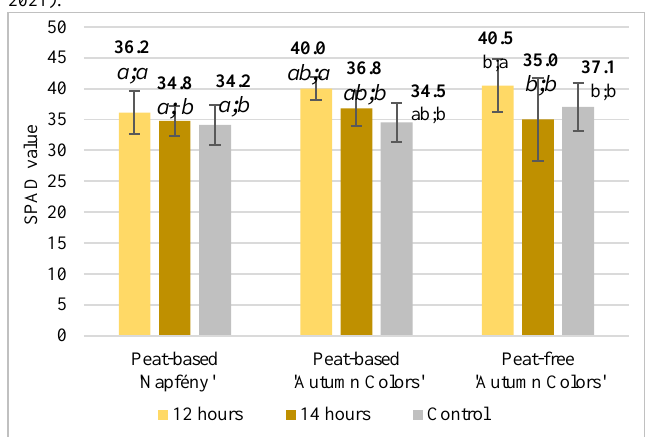
Figure 11. Relative chlorophyll content (SPAD value) of Rudbeckia hirta L. varieties (’Napfény’, ’Autumn Colors’) depending on photoperiodic lighting treatments, peat-free and peat-based media (University of Debrecen, Biological Research and Plant Experiment Greenhouse - Biodrome, Debrecen, Hungary, 2021).